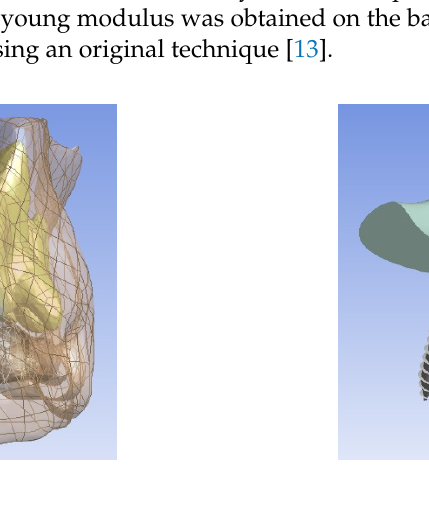
Figure 2. Four investigated mini-implant configurations. Bottom view. ( a ) Model 1. ( b ) Model 2. ( c ) Model 3. ( d ) Model 4. Figure 3 shows the 3D model with the bite plane which is highlighted with green color. Figure 3. 3D jaw model with installed POD and bite plane. For each mini-implant configuration, a static theory of elasticity problem was consid- ered—the upper part of the jaw was rigidly fixed, and a constant force of 100 N was ap- plied to the surface of the bite plane (Figure 4) [14–16]. Thus, the task of applying a chew- ing load to the POD was simulated.